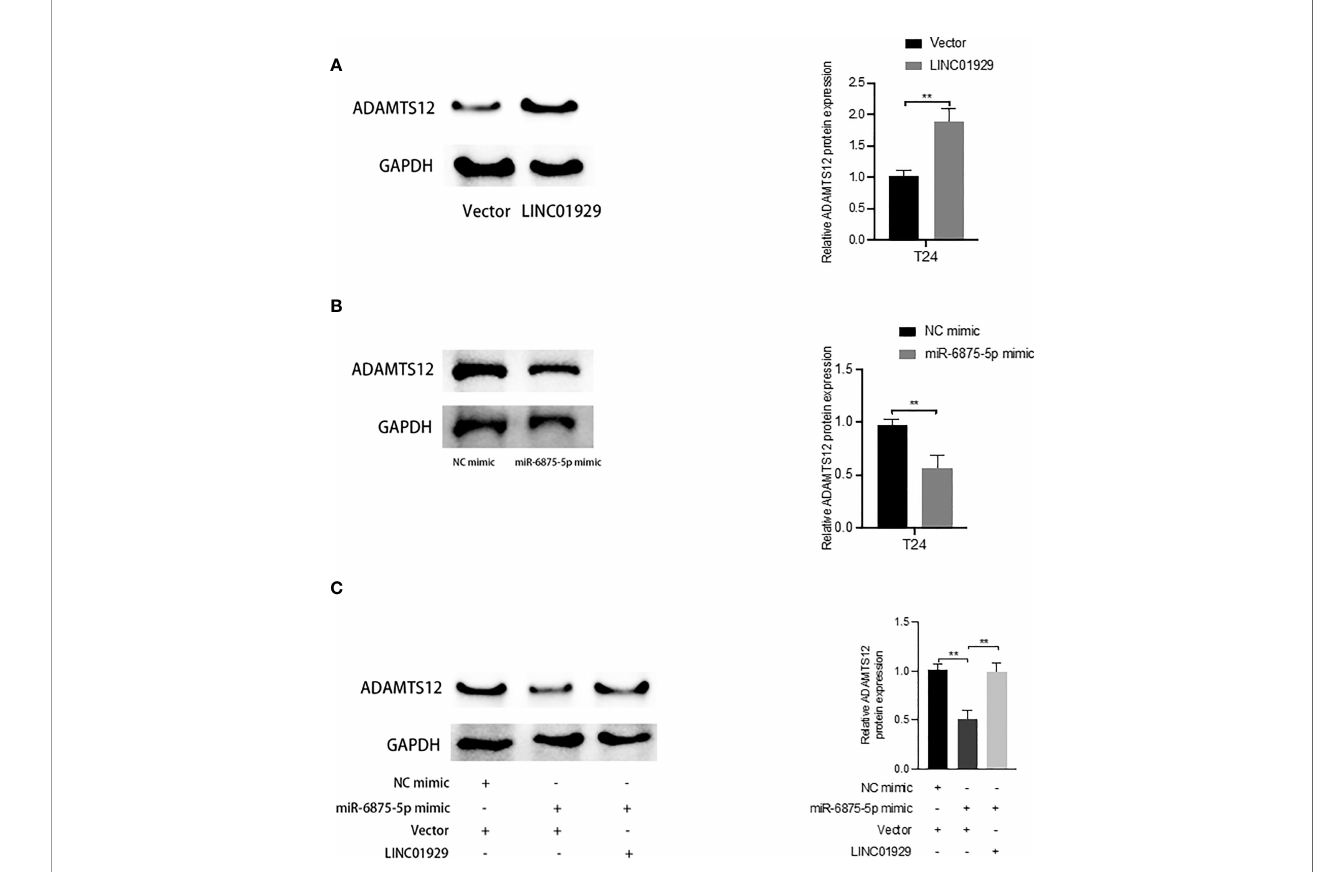
FIGURE 11 | LINC01929 antagonizes miR-6875-5p mediated repression of ADAMTS12 expression. (A, B) The effect of LIN01929 and miR-6875-5p overexpression on ADAMTS12 protein expression levels in T24 cells was assessed by Western blotting. (C) Western blotting analysis of the effect of overexpressed LIN01929 on ADAMTS12 expression in T24 cells induced by miR-4875-5p overexpression. **P <